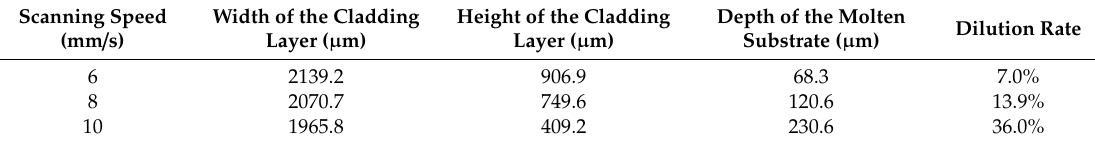
Figure 2. Cross sections of the laser cladding coatings for different scanning speeds: ( a ) 6 mm/s; ( b ) 8 mm/s; ( c ) 10 mm/s. Table 3. Average geometric parameters and dilution rates for the different scanning speeds.